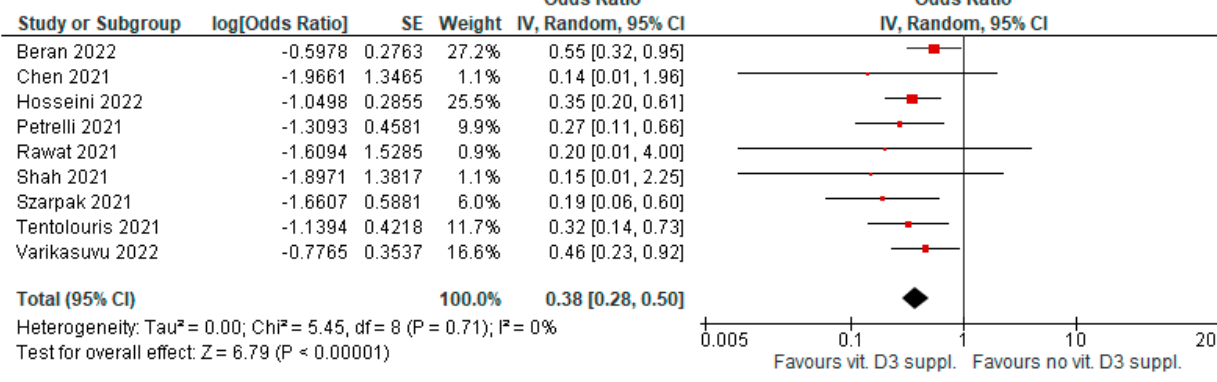
Figure 5. Forest plot showing results for the association of vitamin D3 supplementation and COVID-19 severity.